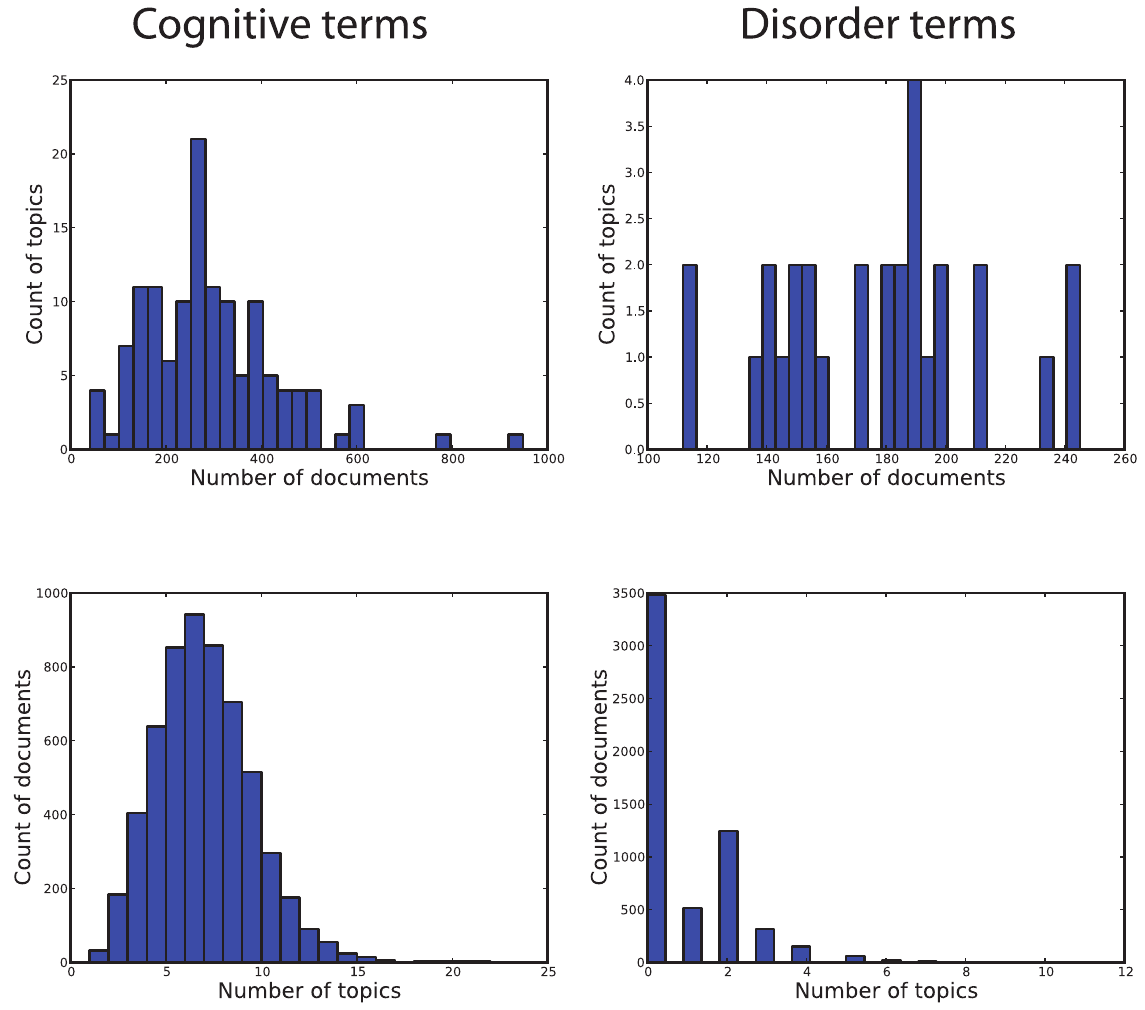
Figure 3. Histograms of the number of topics per document (top row) and documents per topic (bottom row) for cognitive terms (left column) and disorder terms (right column).